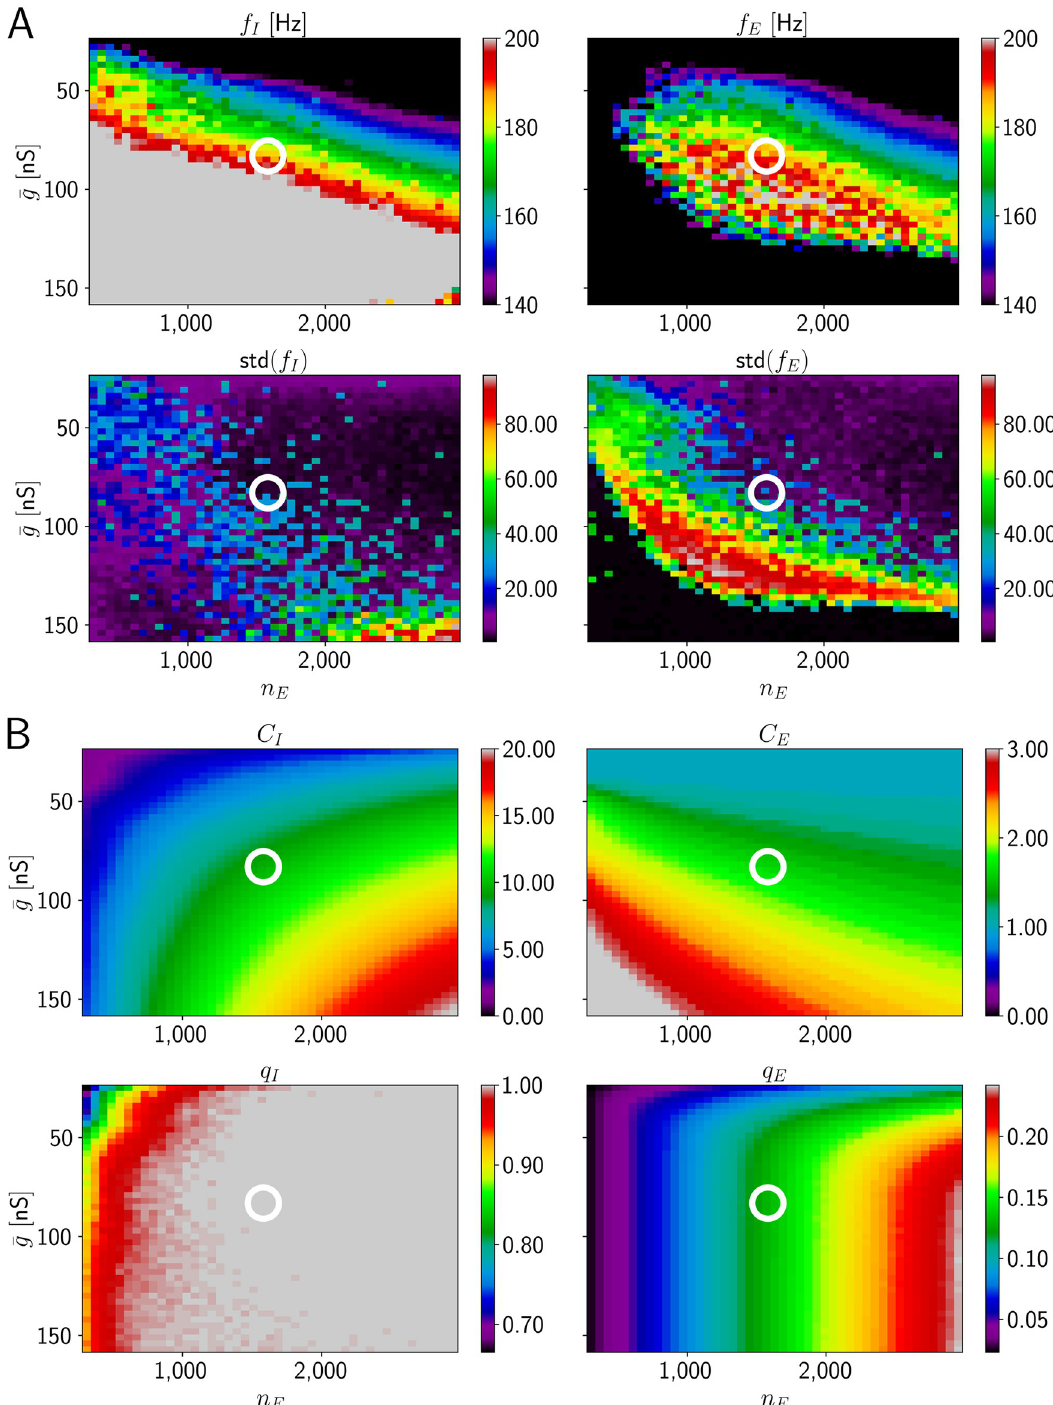
Fig 6. HFOs in networks with temporally narrow excitation of E cells (model 2). Ripple oscillation generation with sparse spiking of E neurons is robust in networks where the E cells are driven by short input pulses. Figure layout as in Fig 4. A: Frequency of population activity oscillations and standard deviations. B: Number of spikes per active neuron and fraction of active neurons. The ranges for C and C are [0, 20] and [0, 3], respectively. The white circle is located at ð � g ; n I E σ g = 3